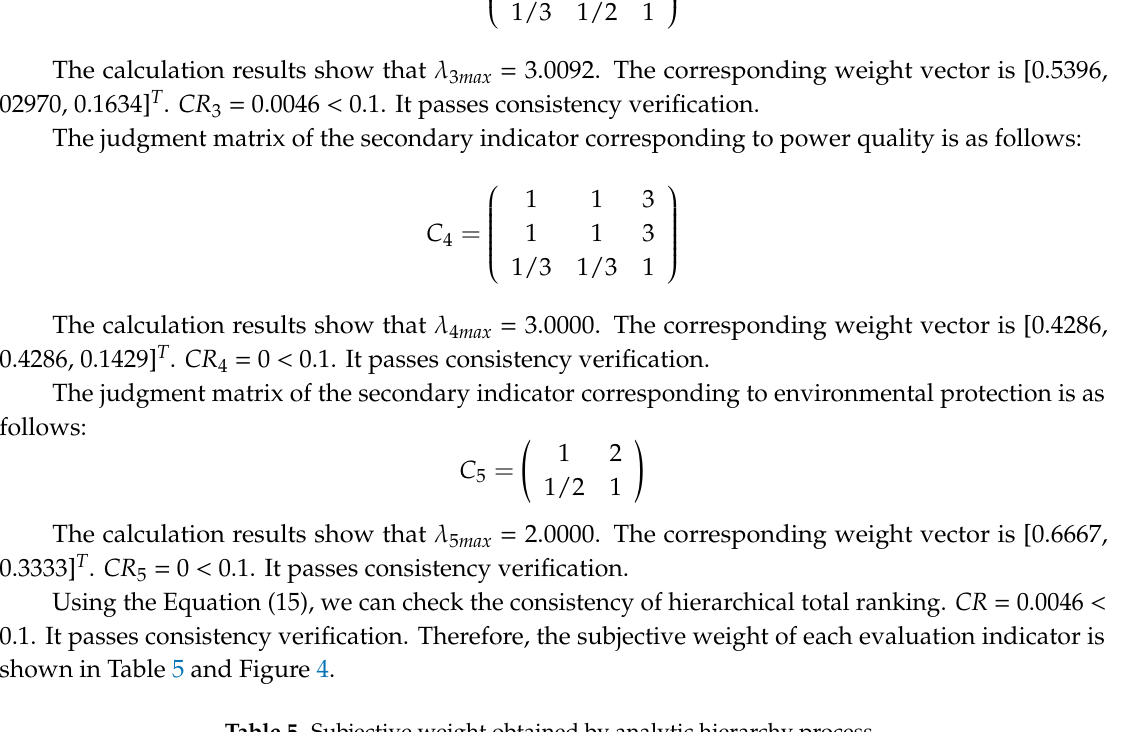
Table 5. Subjective weight obtained by analytic hierarchy